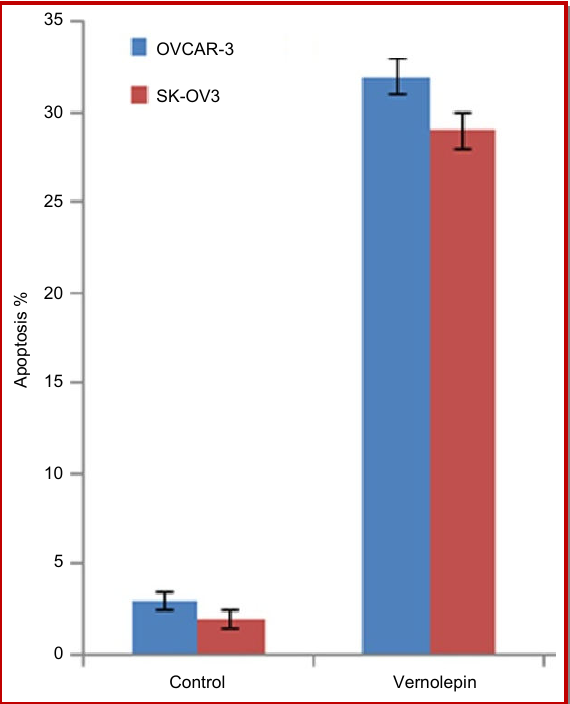
Figure 4 : Protective role of autophagy in vernolepin-treated OVCAR-3